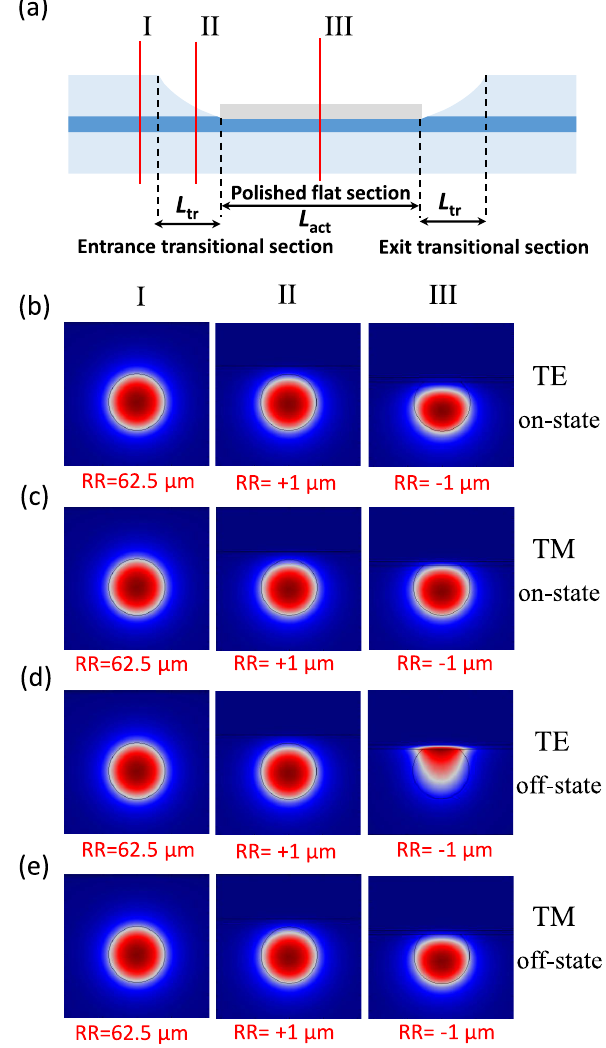
Figure 6: (a) The schematic side view of the SPMS-based SPF. (b) TE mode profiles of the on-state at three different points at (I) entrance tapered region, (II) center of the polished flat region, and (III) exit tapered region. (c) TM mode profiles of the on-state, (d) TE mode profiles of the off-state, and (e) TM mode profiles of the off-state at three different points. The red values below each graphs shows the residual radius of the structure at each